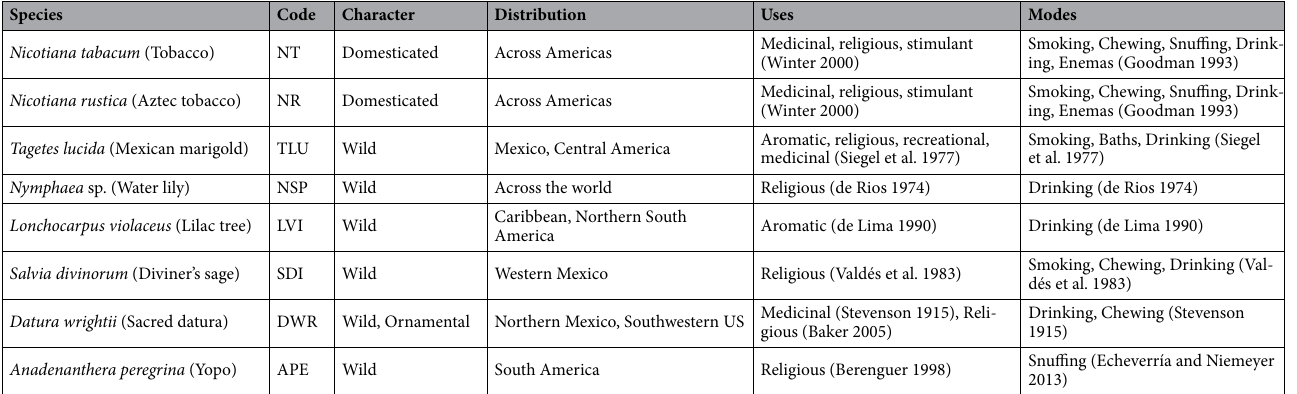
Table 2. List of reference species including information on human management and